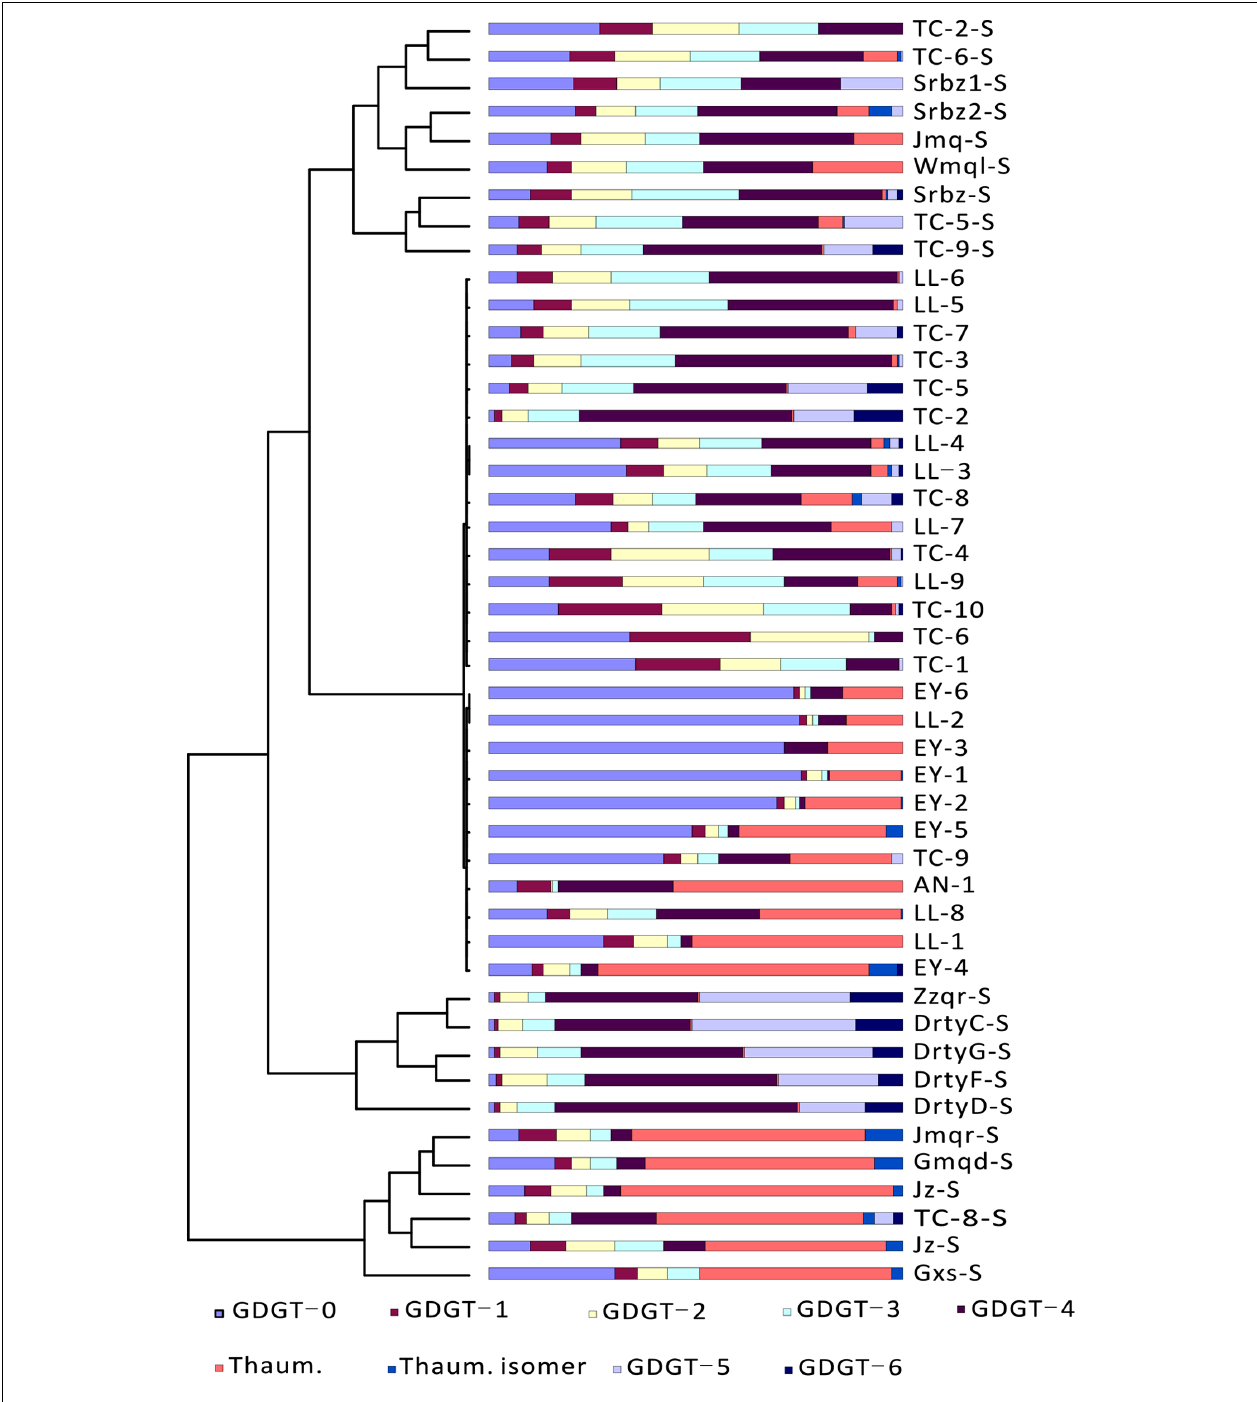
FIGUREA2 | Cluster analysis of archaeal lipids from Yunnan hot spring sediments in this study and surrounding soils (Xie etal., unpublished data). Samples named with “S” are from soils surrounding hot springs. TC-1, Dagunguo; TC-2, Diretiyanqu; TC-3, Yanjingquan; TC-4, Yanjingquan; TC-5, Zhenzhuquan; TC-6, Gumingquan; TC-7, Dawumingquan; TC-8, Wumingxiaoxishangyou; TC-9, Wumingxiaoxizhongyou; TC-10, Hamazui;